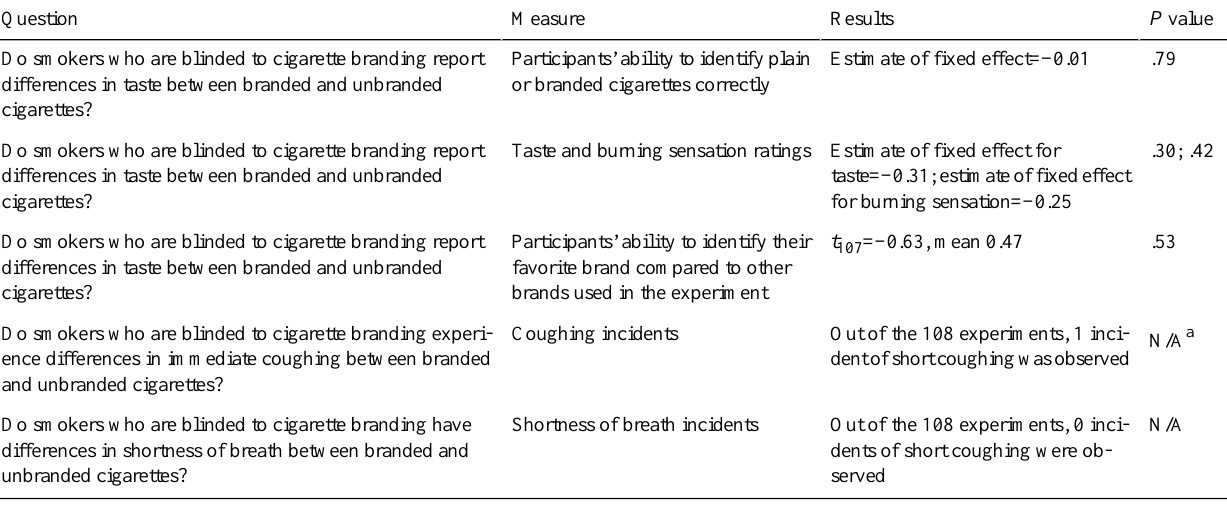
Table 1. Summary of the results for the main questions of this